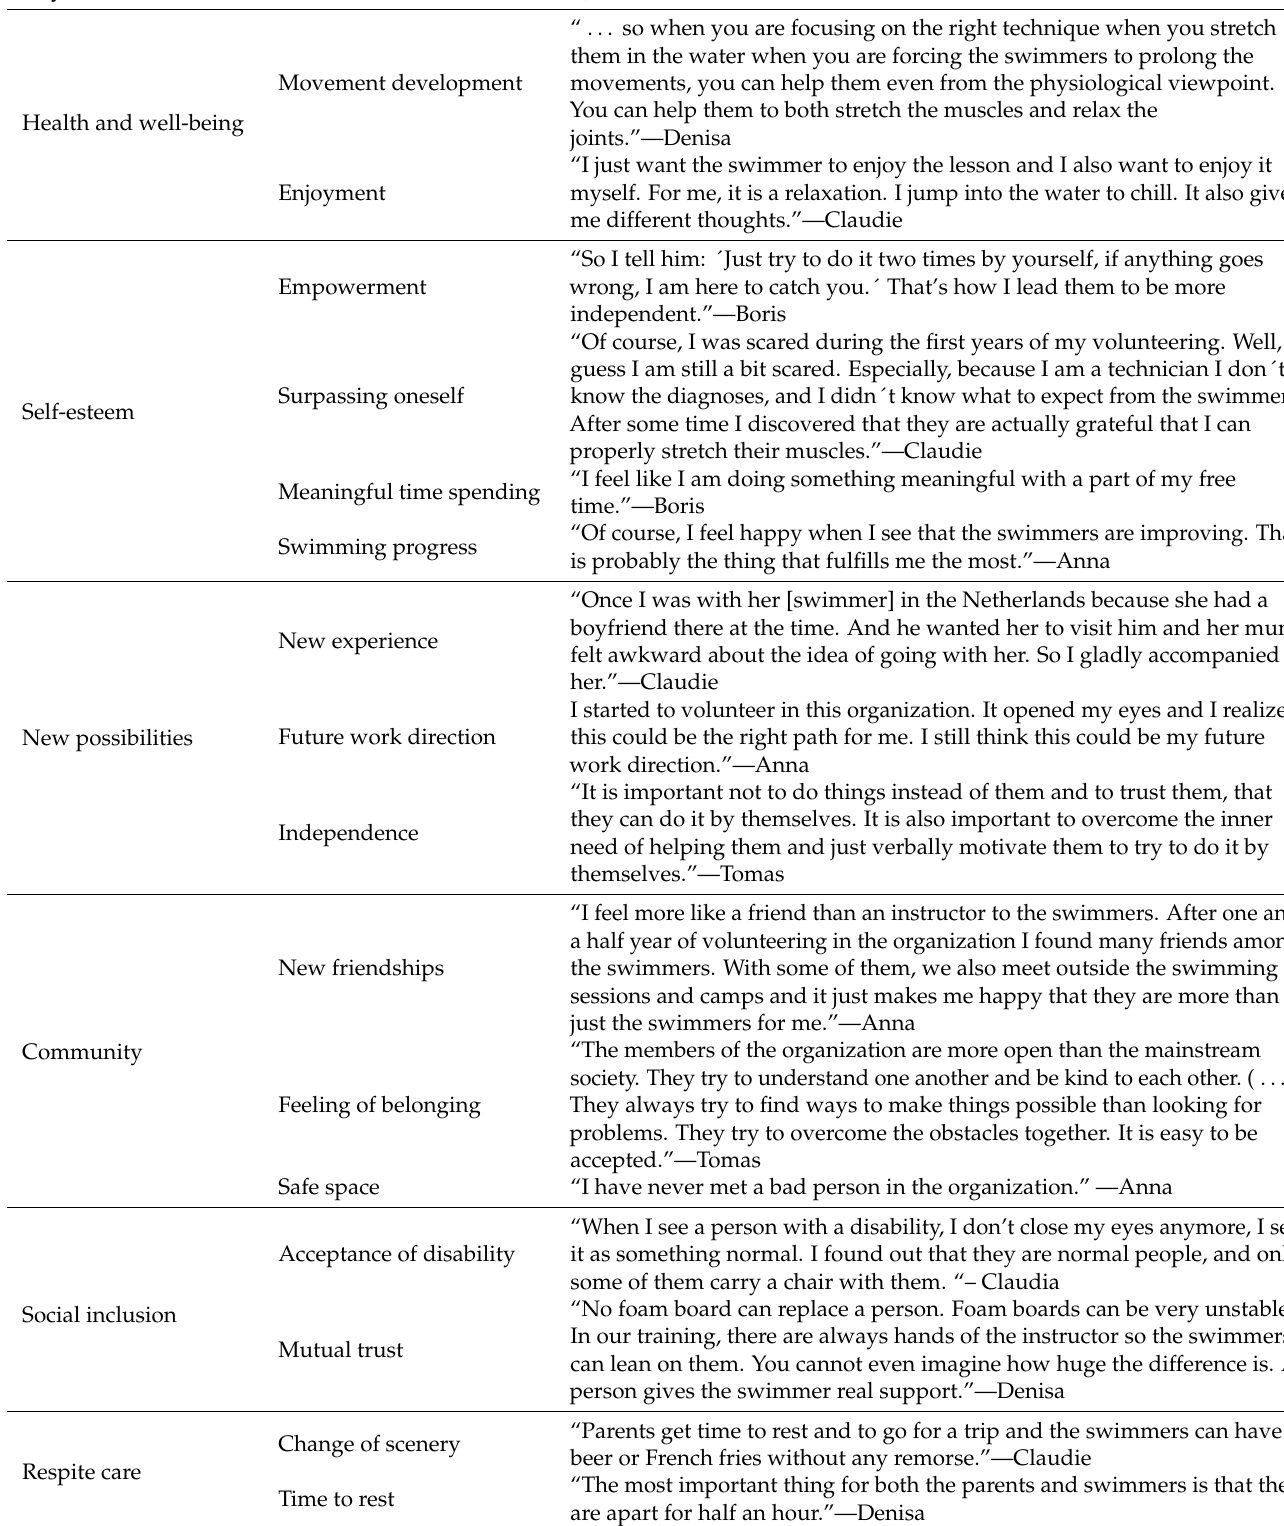
Table 4. Instructors’ quotes according to the mentioned